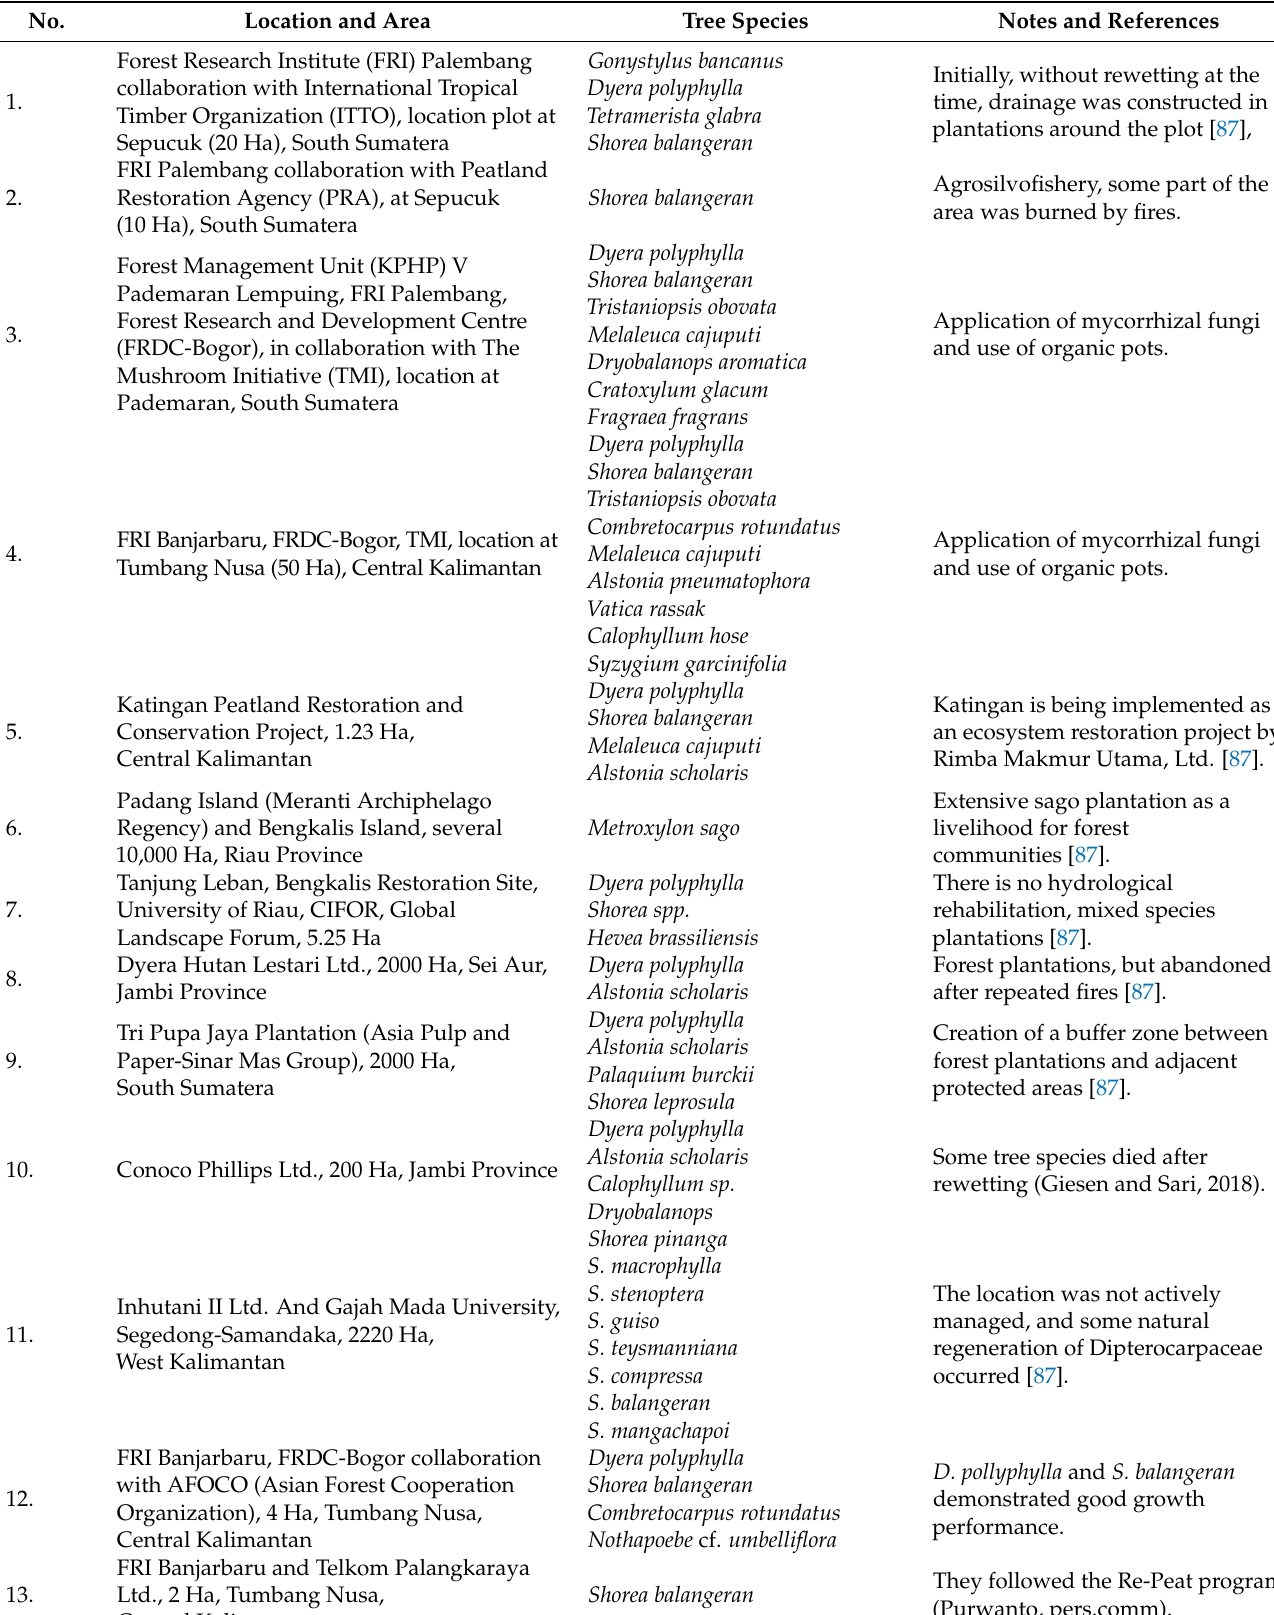
Table 3. Revegetation trial activities and development forest plantation in degraded ecosystem peat swamp forests in